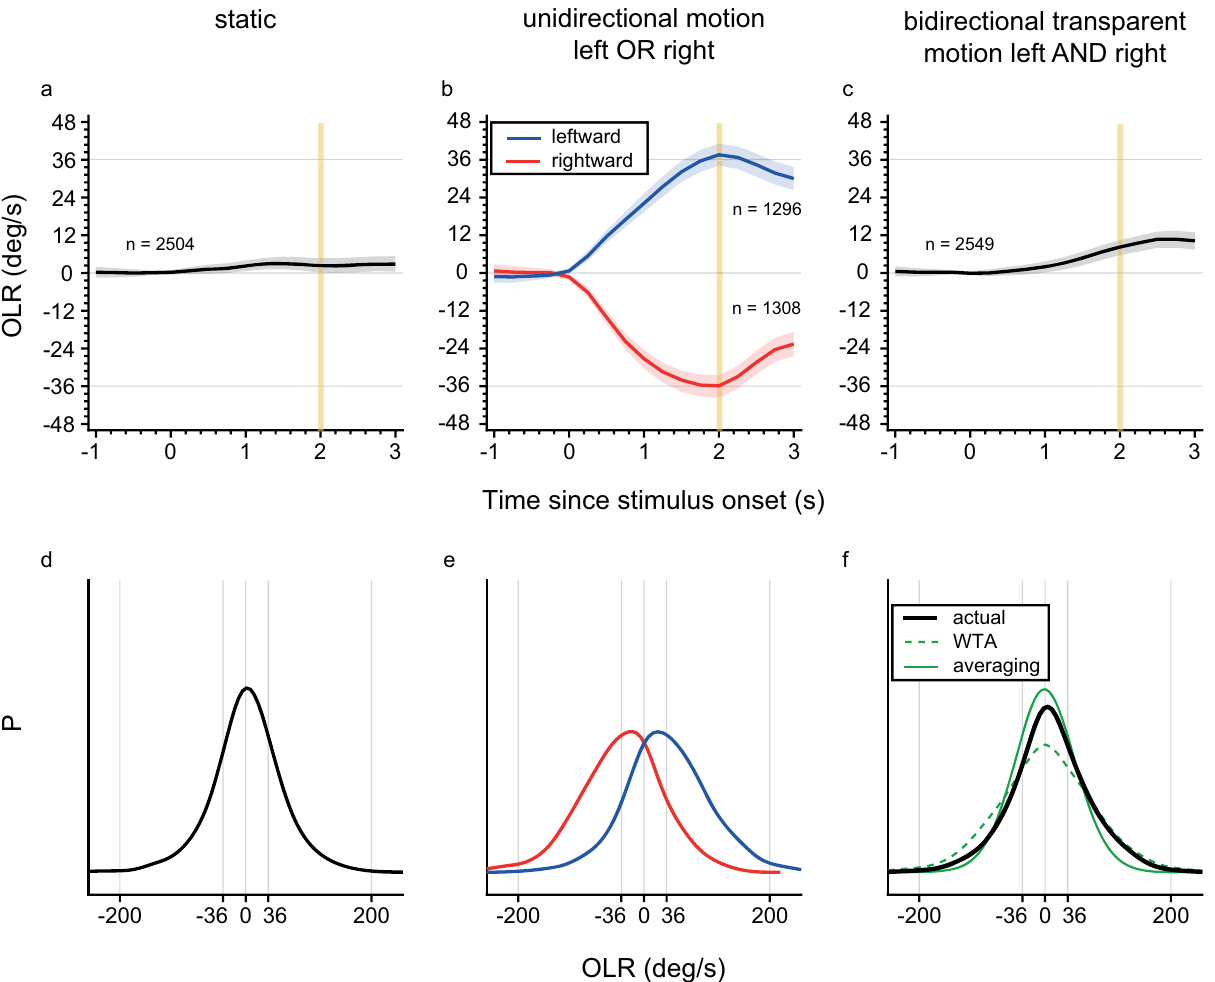
Figure 2. OLR mean and probability distributions. ( a – c ) Mean OLRs over time averaged across trials of five mice for the ( a ) static, ( b ) unidirectional left (blue) or right (red) and ( c ) bidirectional visual motion stimuli. Shaded areas represent 95% confidence intervals of the mean across trials. Trial numbers are depicted in each panel. The vertical yellow lines indicate end of stimulus, 2 s after stimulus onset. ( d – f ) OLR probability distributions determined at 2 s after stimulus onset are shown for each stimulus, including response variability. ( f ) The OLR probability distributions according to the WTA (dashed green line) and averaging (solid green line) readout rules are predicted from the actual unidirectional motion response data in ( e ). The actual OLR probability distribution is represented by the solid black